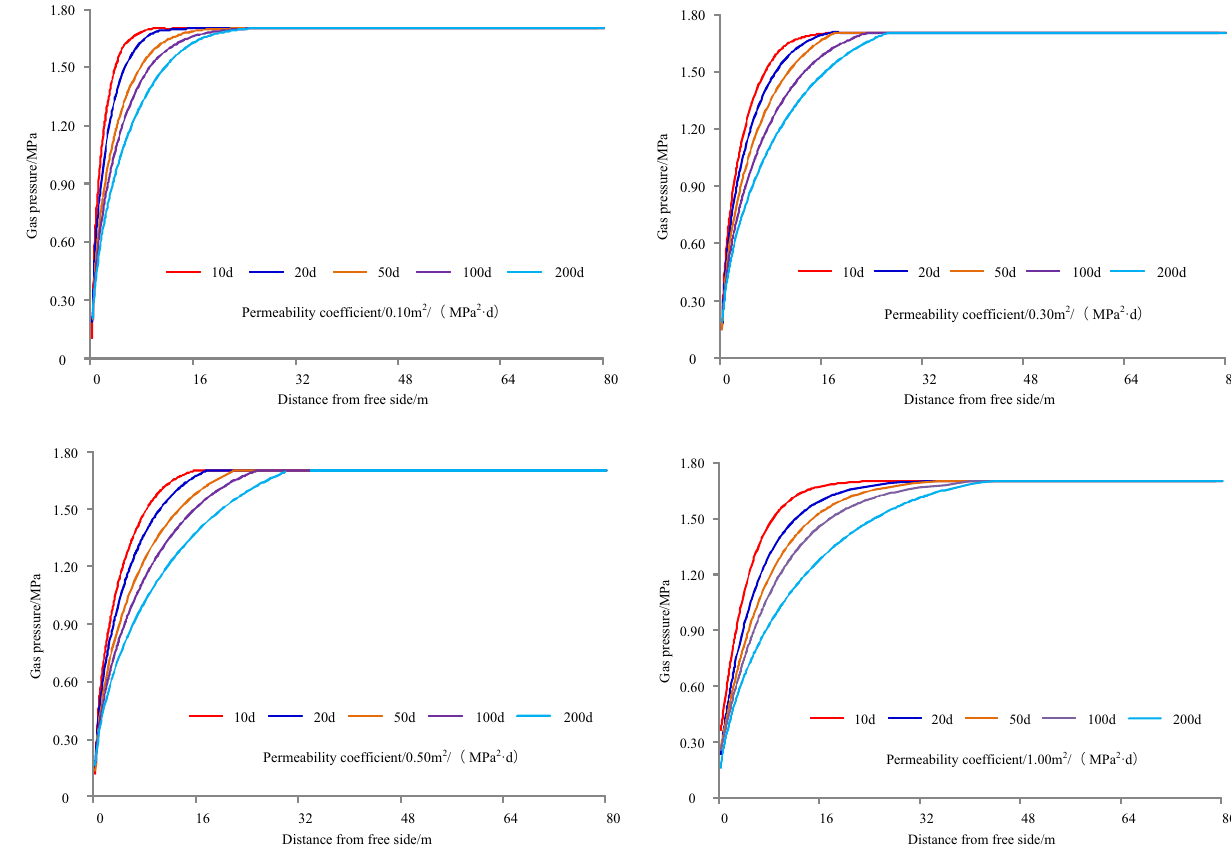
Figure 6. Gas emission zone under different permeability coefficients.